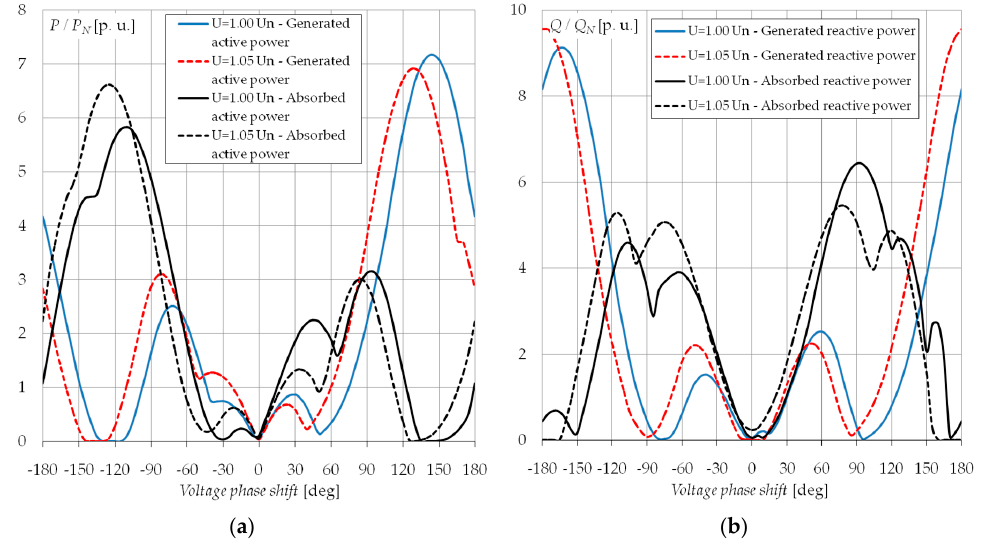
Figure 11. Generated and absorbed active ( a ) and reactive power ( b ).